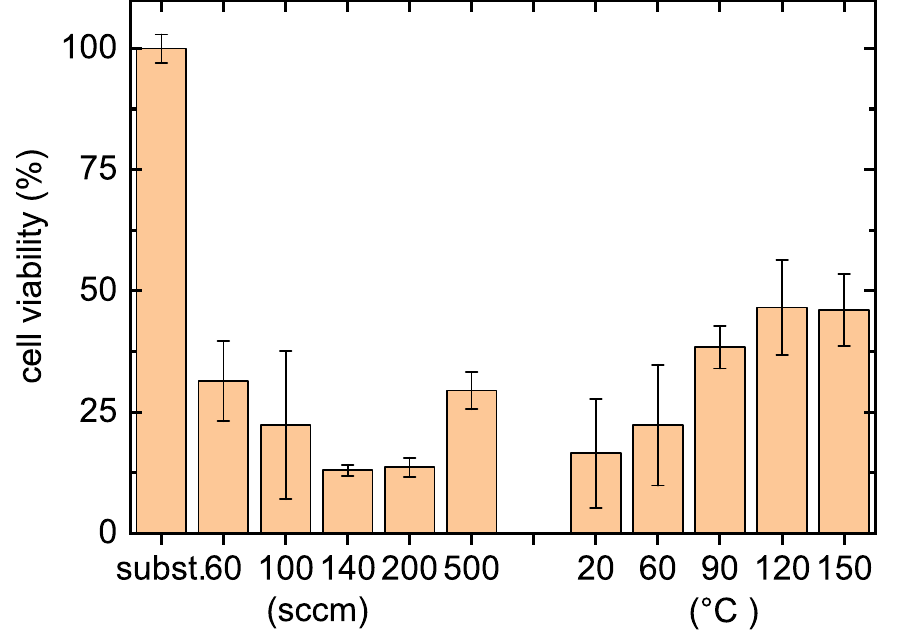
Figure 3. In vitro cytocompatibility results of tested POx films deposited at different substrate temperatures and at different flow rates through the monomer. Left side of graph—films deposited at different flow rates through the monomer; right side of graph—films deposited at different substrate